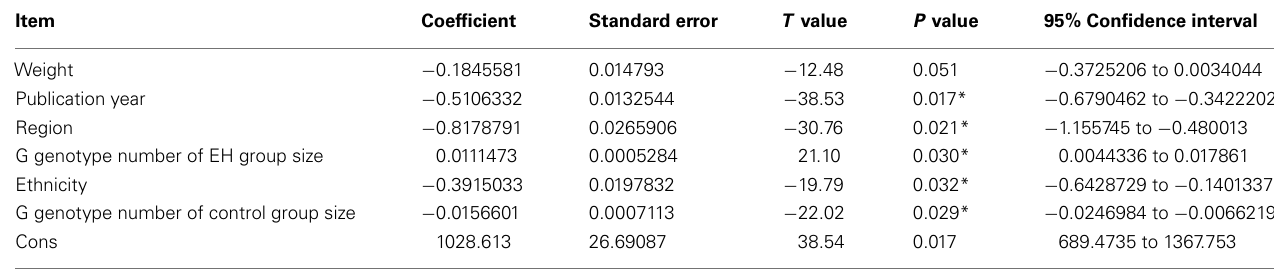
Table 2 |The meta-regression results among eight studies in the male subgroup under the allelic genetic